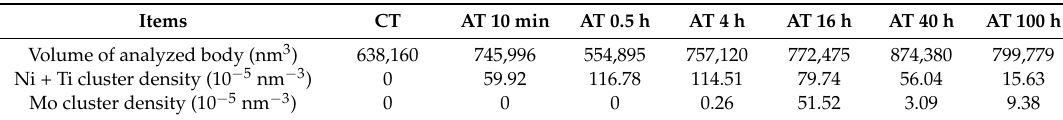
Figure 5. Three-dimensional reconstruction of the atomic positions of Ni ( green points ), Ti ( grey points ) and Mo ( red points ) for specimens aged at 753 K for different time. All the analyzed volumes are with the dimension of 30 × 30 × 80 nm 3 . Table 2. Cluster analysis of specimens under different aging conditions. (Ni + Ti cluster: d max = 0.5, N min = 100; Mo cluster: d max = 0.5, N min = 10).